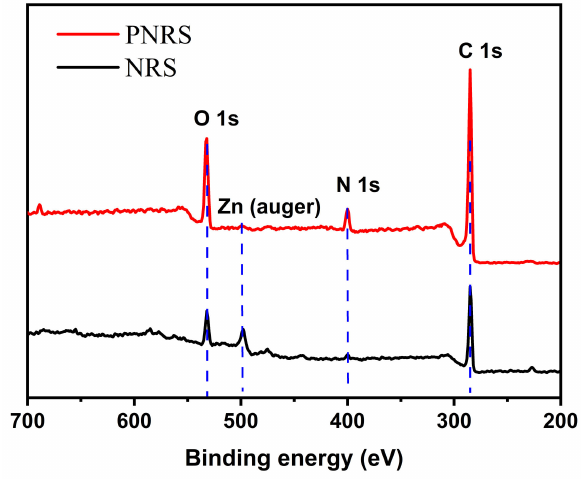
Figure 3. XPS curves of NRS and PNRS.